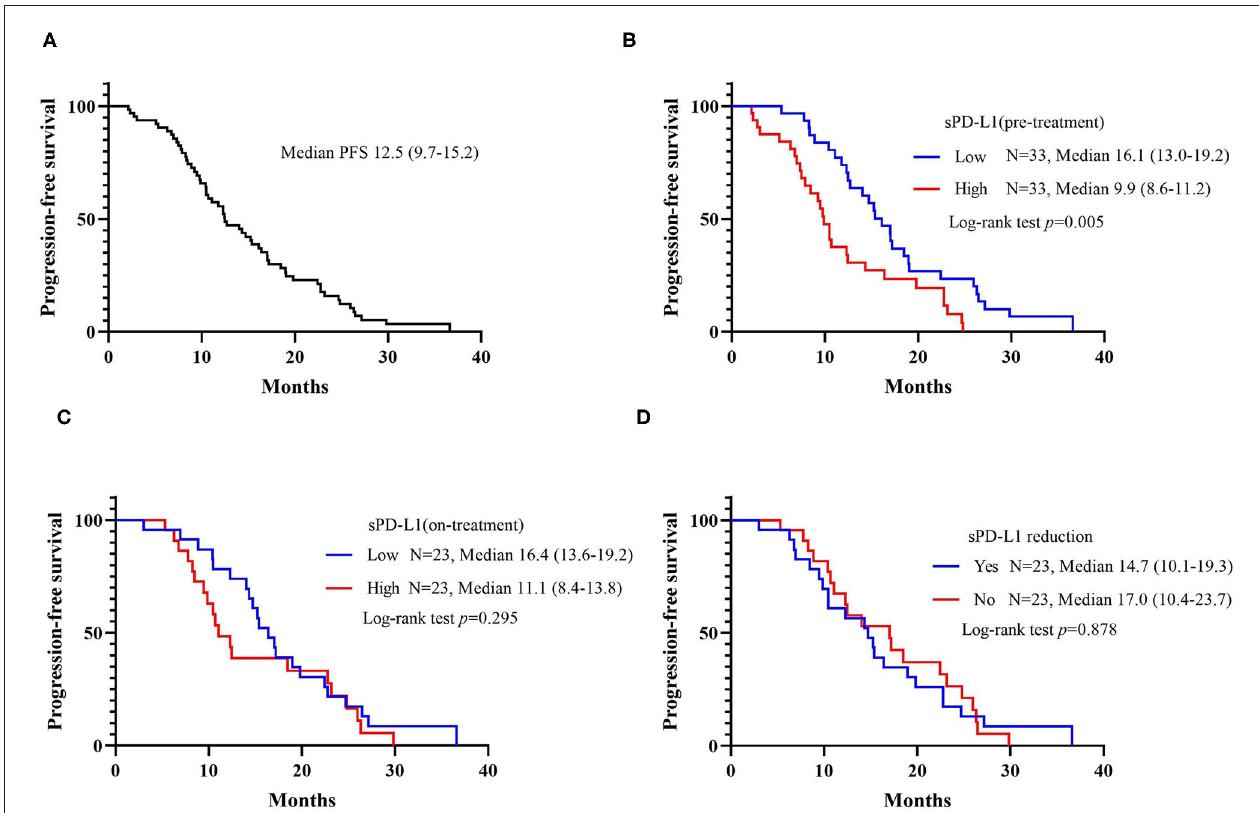
FIGURE 2 | Kaplan-Meier curves for progression-free survival (PFS). (A) PFS among all patients. (B) PFS according to the baseline level of sPD-L1. (C) PFS according to the sPD-L1 levels 1 month after initiating EGFR-TKI treatment. (D) PFS according to the changes in sPD-L1 during EGFR-TKI treatment.